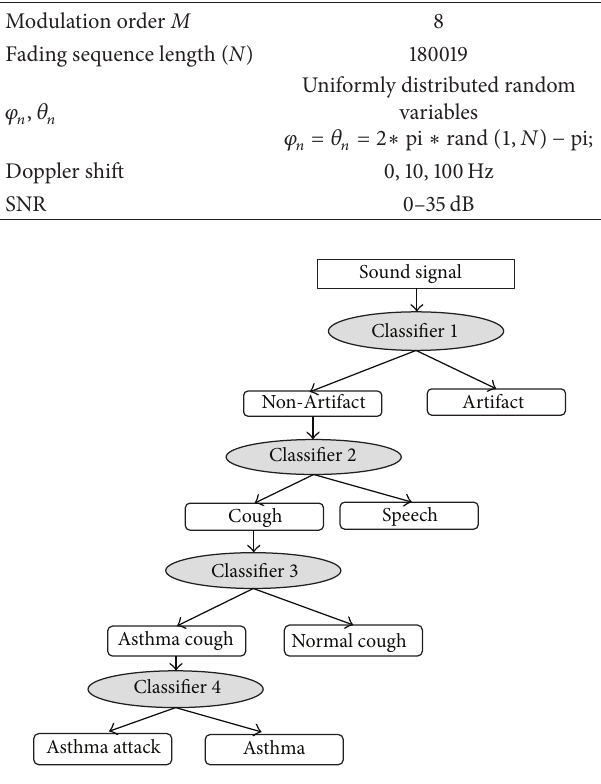
Figure 5: Tree SVM classifier for detection of asthma attacks.